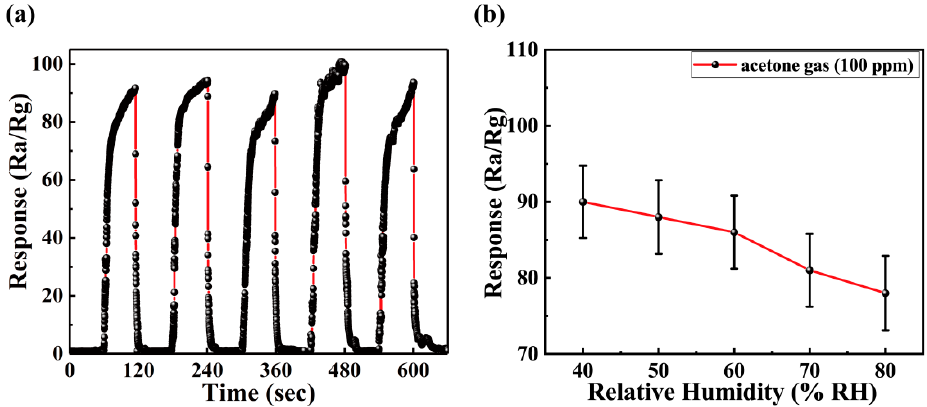
Figure 6. ( a ) Reproducibility of the ZnO/GO NSs-525 to 100 ppm of acetone at 400 °C; ( b ) response values to 100 ppm acetone at different relative humidity.